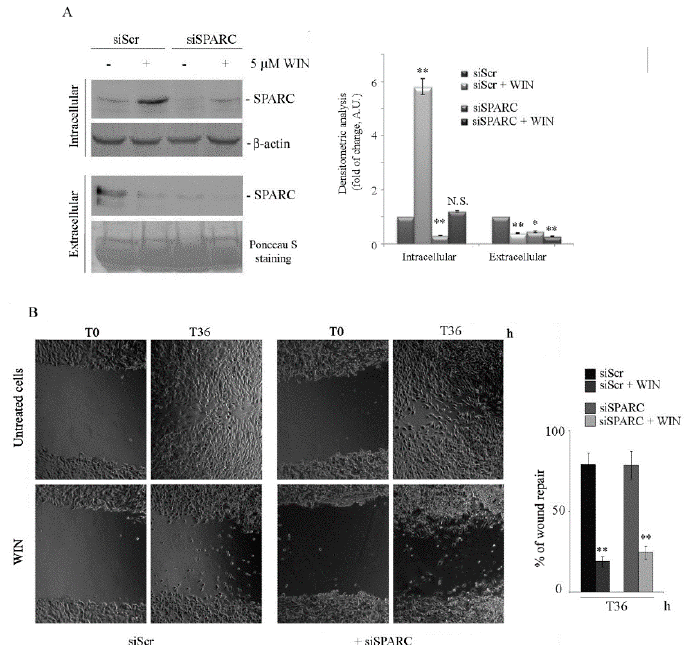
Figure 5. The effect of WIN on MG63 cell migration is not dependent on SPARC . ( A ) The effect of SPARC siRNA (siSPARC) on the protein level under 5 µM WIN treatment in both intracellular or extracellular fractions. β -actin blot or Ponceau red staining were reported as a loading control for intracellular or extracellular protein levels, respectively. Representative blots of three independent experiments and densitometry analysis histograms are depicted. (*) p < 0.05, (**) p < 0.01 compared to the untreated sample at the same time point. N.S. not significant. ( B ) Effects of siSPARC on cell migration in comparison with scramble control (siScr). Pictures reported were taken at T36 after wounding (magnification 200×). The average distances between cells at the edges of the gaps in the wound healing assay were estimated through ImageJ software. On the right panel, a graph of the mean percentage area healed at T36 post-wounding is shown. (**) p < 0.01 compared to untreated cells at the same time point. N.S. not significant.